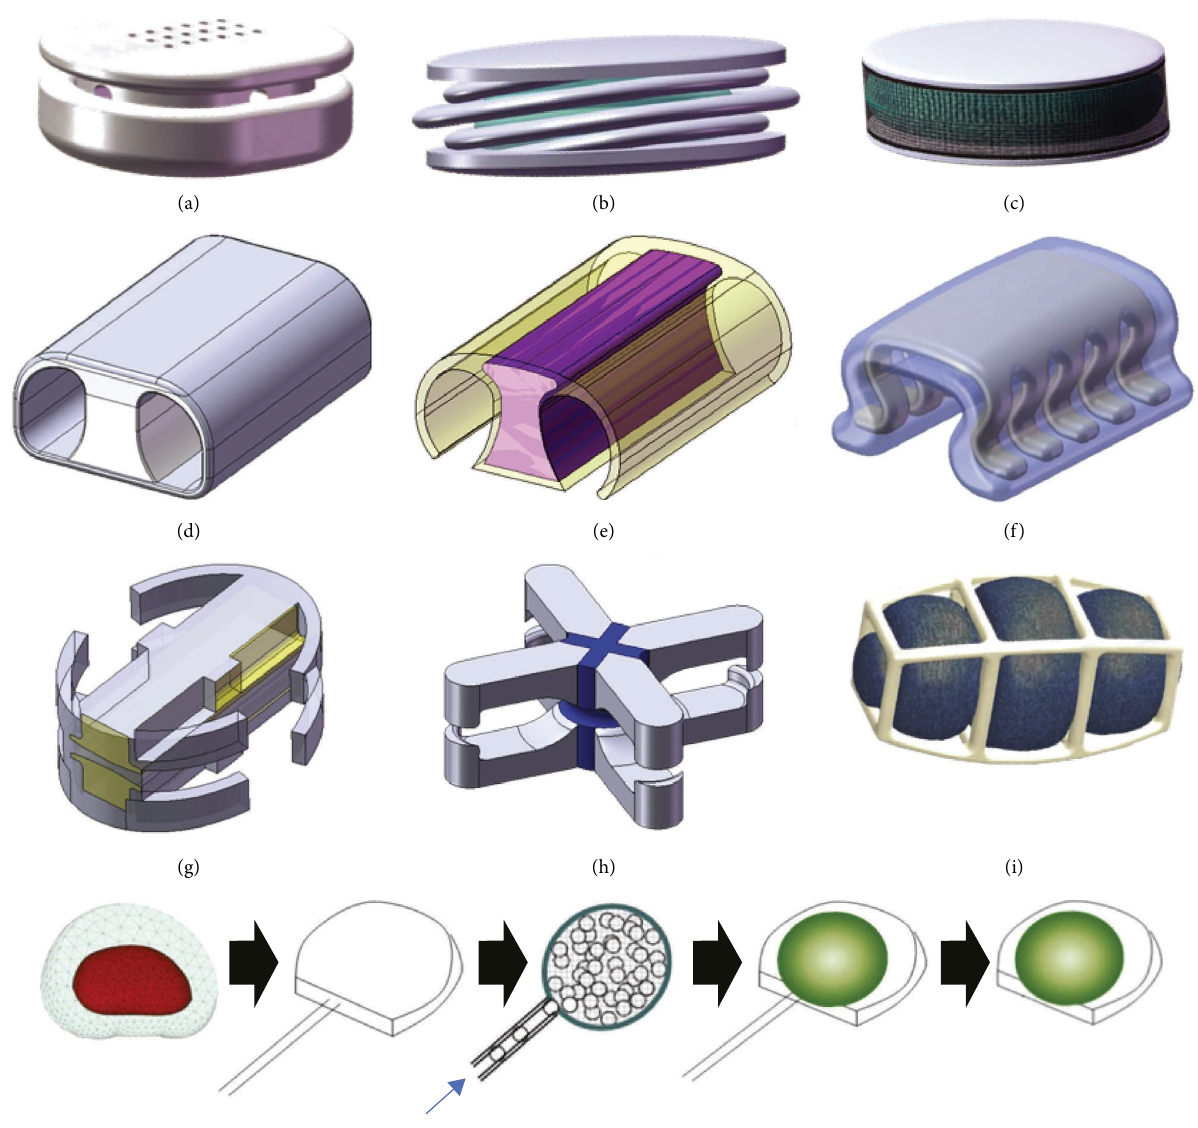
Figure 2: Sandwich designs that we evaluated in this study. We can group them into shock absorbing (a–c), dampening (d–f), shape memory (g–i), and balloon type